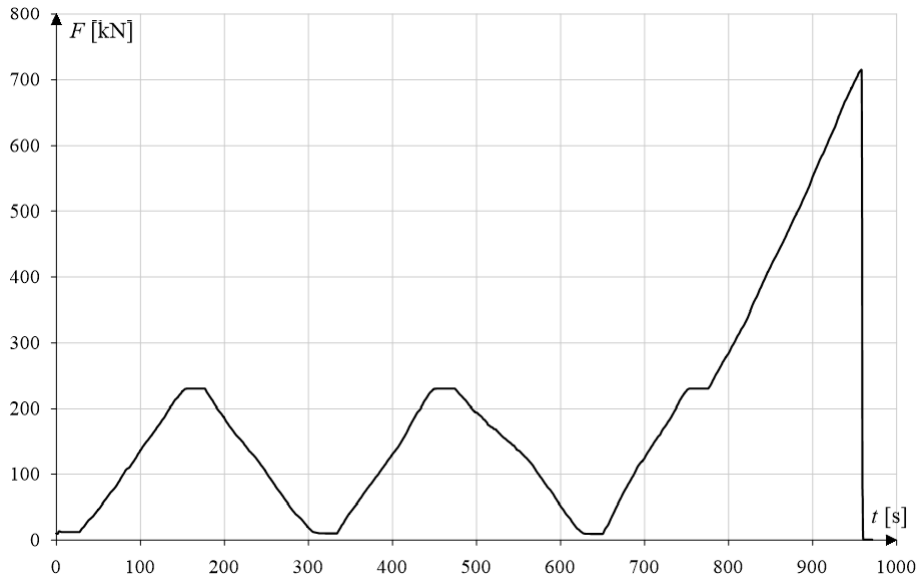
Figure 7: Diagram of specimen loading according to method I.